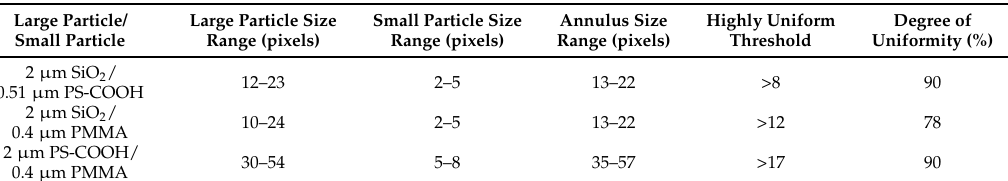
Table 1. Particle combinations used to fabricate BCCs, parameters for calculating the degree of uniformity and the corresponding degrees of uniformity in %.